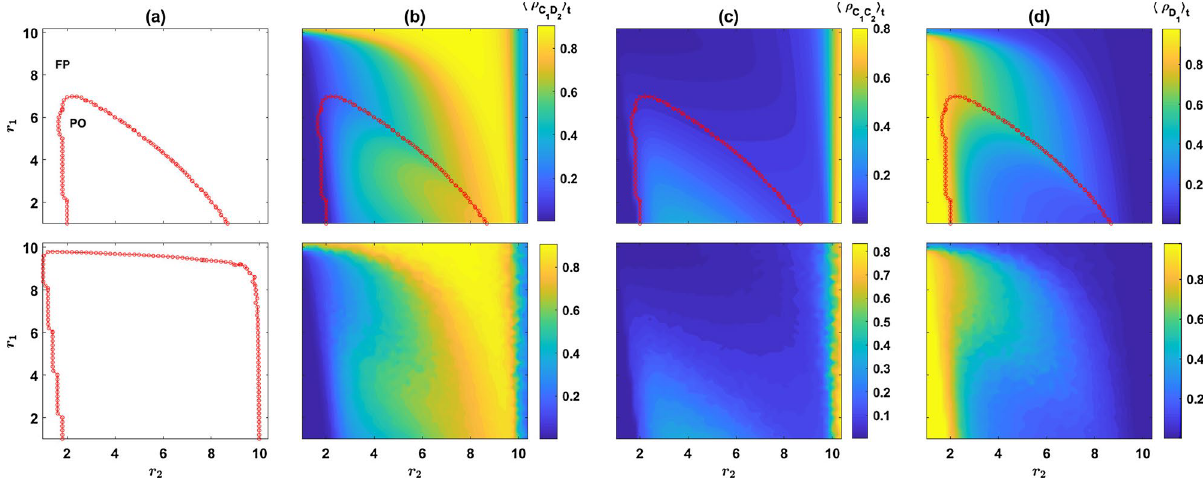
Figure 1. A reward dilemma solves the social dilemma. ( a ) The phase diagram of the model derived from solutions of the replicator dynamics, for two different mutation rates (top ν = 10 − 3 and bottom ν = 10 − 5 ). The dynamics settle in a periodic orbit or a fixed point depending on the parameters of the model. ( b )–( d ) Color plots of, respectively, (cid:31) ρ C 1 C 2 (cid:30) t , (cid:31) ρ C 1 D 2 (cid:30) t and � ρ D 1 � t = � ρ D 1 C 1 + ρ D 1 D 2 � t . Top panels result from solutions of the replicator dynamics, and bottom panels result from simulations. Cooperation evolves in the second game ( c ) and is maximized for moderate values of r 2 . This renders entering the second game an incentive to cooperate in the first game, which promotes cooperation in the first game. Here, g = 10 , c = 1 , and π 0 = 2 . In ( b )–( d ), ν = 10 − 3 . Simulations are performed in a population of size N = 5000 . The simulation is performed for T = 3000 time steps starting from an initial condition with random assignment of strategies, and the time averages are taken over the last 2000 time steps. The replicator dynamics are solved for T = 5000 time steps starting from homogeneous initial conditions. Time averages are taken over the last 2000 time steps. As the model is mono-stable in the entire phase diagrams, the results are independent of the initial